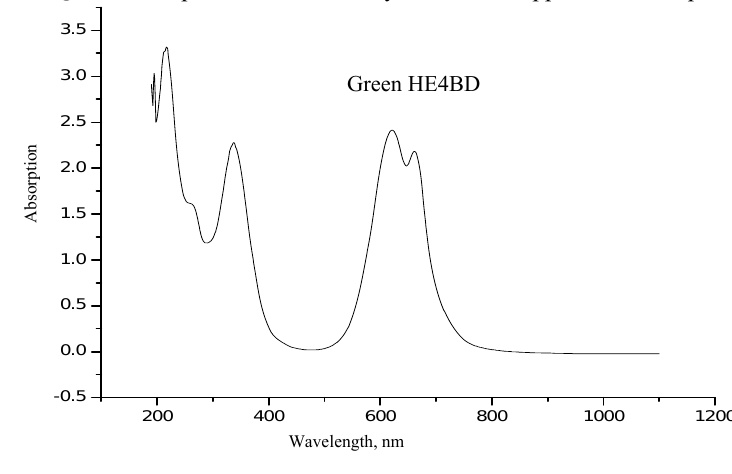
Figure 3. IR spectral data of azo dyes and azo-copper metal